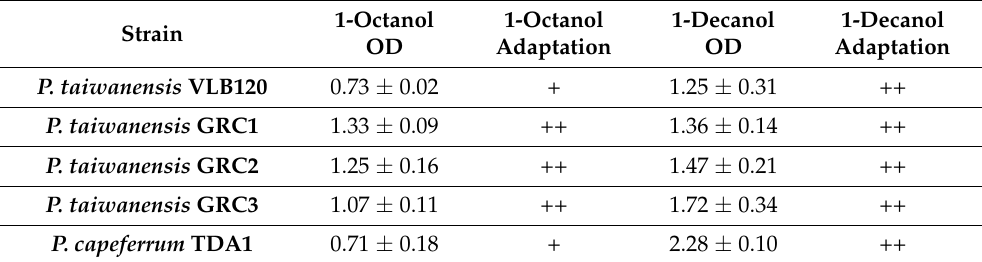
Table 3. Bacterial growth (OD 560 ) adaptation to a second phase of 1-octanol and 1-decanol present in concentrations of 1% ( v / v ). +: adapted (OD 560 between 0.5 and 1 after 24 h incubation with 1% ( v / v )), ++: well-adapted (OD 560 above 1 after 24 h incubation with 1% ( v / v )). The errors are given as standard error of the mean (n =